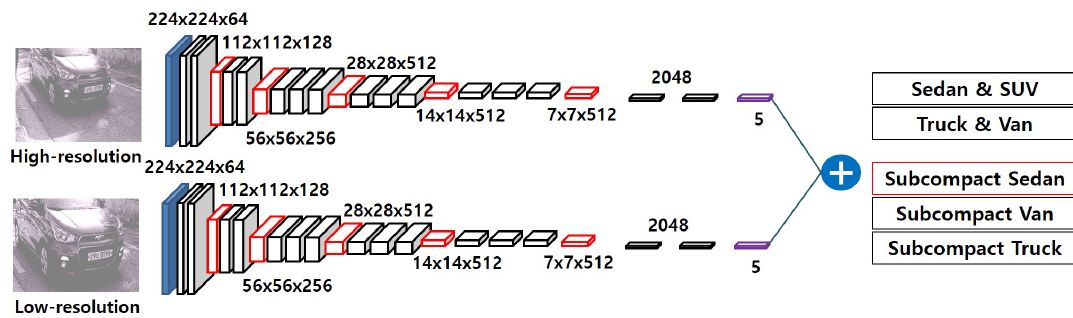
Figure 7. The architecture of the proposed multi-resolution network. Blue, black, and red cubes represent the resized input, convolution, and max-pool layers, respectively. Black and purple boxes are fully-connected and softmax layers,